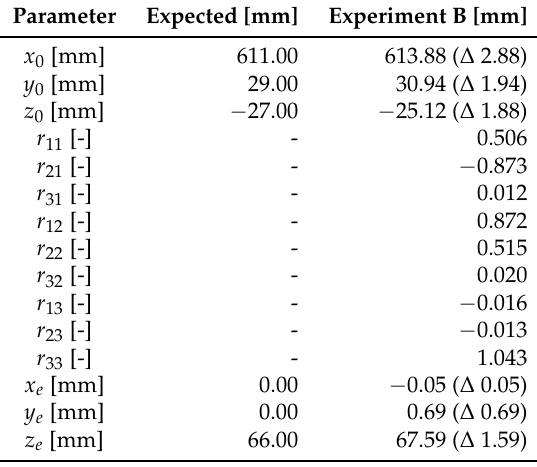
Table 5. Results of experiment B for the X vector after